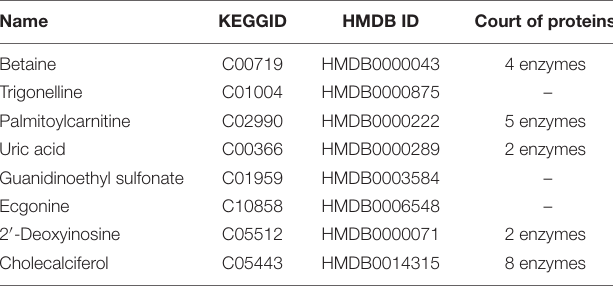
TABLE 3 | Different metabolites in cortical traumatic brain injury and related proteins revealed by the Human Metabolome Database analysis.